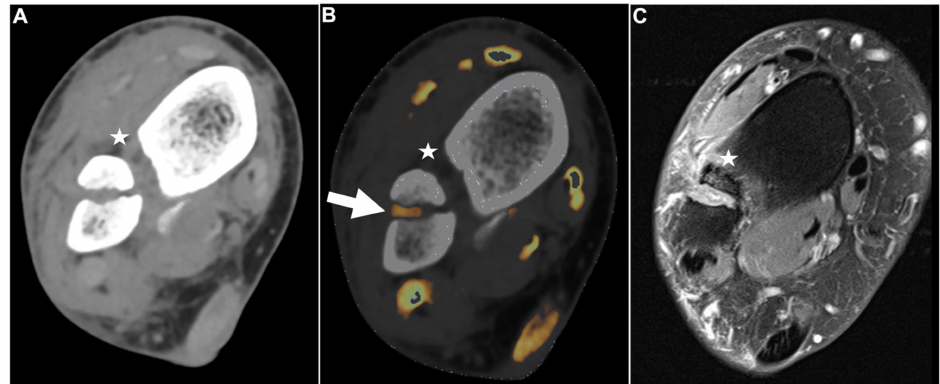
Figure 5. Fractured fibula with DTFS tear. Standard axial unenhanced grayscale CT ( A ), color-coded collagen reconstructions ( B ), and proton density-weighted unenhanced MRI series with fat saturation ( C ) of a fractured fibula with rupture of the ATIFL ( stars ). Notably, in the grayscale images, the ATIFL is visible ( star ); however, collagen mapping reveals no collagen signal, indicating a rupture. Note the distortion of the collagen signal by bleeding in the fractured region ( B, arrow ). MRI confirmed rupture of the ATIFL ( star ) and PTIFL (not pictured due to angulation). Abbreviations: ATIFL, anterior tibiofibular ligament. PTIFL, posterior tibiofibular ligament.